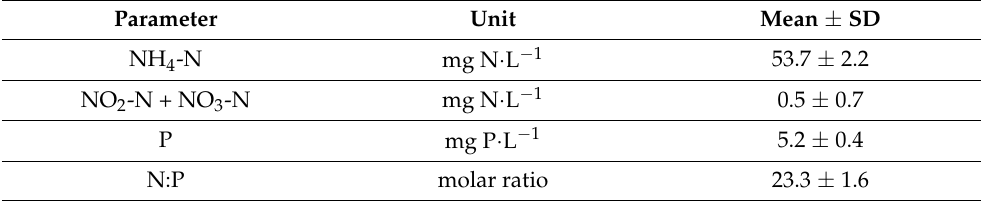
Table 1. Substrate (MPBR influent)